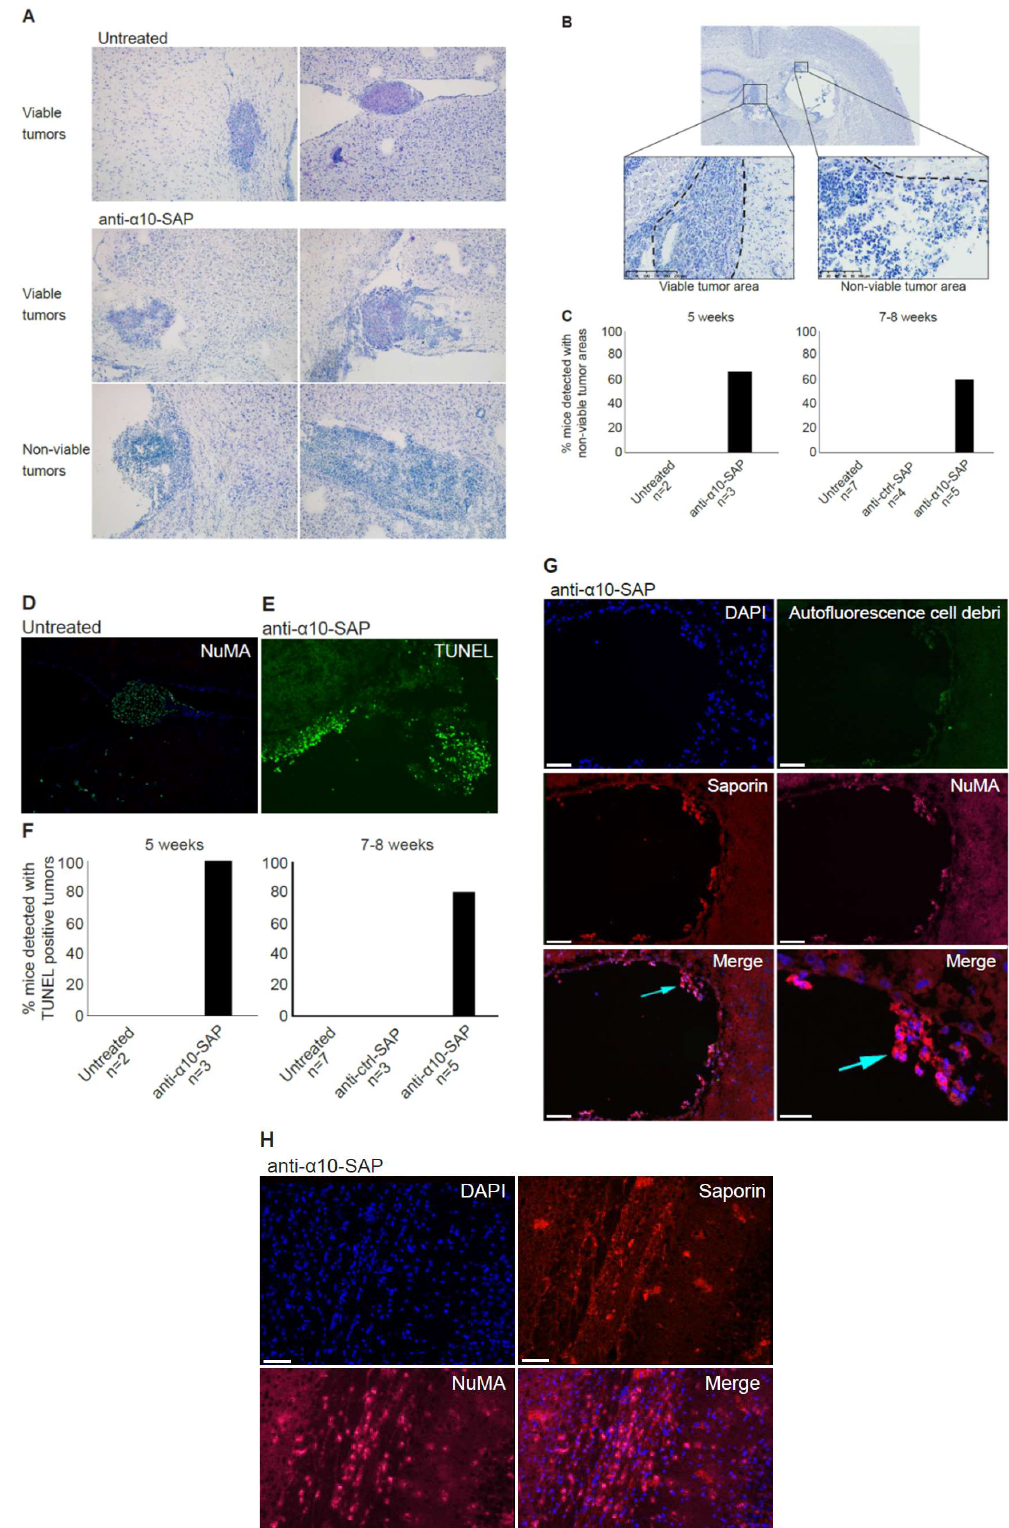
Figure 7. The in vivo efficacy of anti-α10-SAP treatment on GBM cells in an orthotopic xenograft model. GBM orthotopic xenografts were established in nonobese diabetic/severe combined immunodeficiency (NOD-SCID) mice via intracranial (striatum) stereotactic injection of U3054MG cells. Intracerebroventricular injection of anti- α 10-SAP or anti-ctrl-SAP was performed, followed by histopathological assessment of the brains 5 and 7-8 weeks after cell injection. ( A )